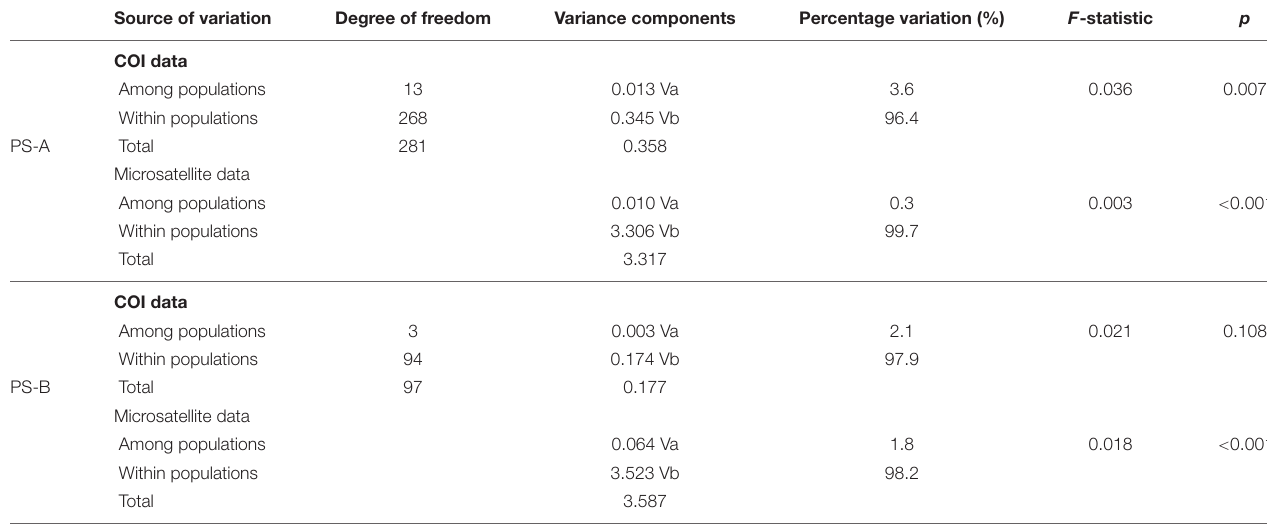
TABLE 2 | AMOVA results based on mtDNA cytochrome oxidase subunit I (COI) and microsatellite data from two Parantica sita lineages: PS-A and